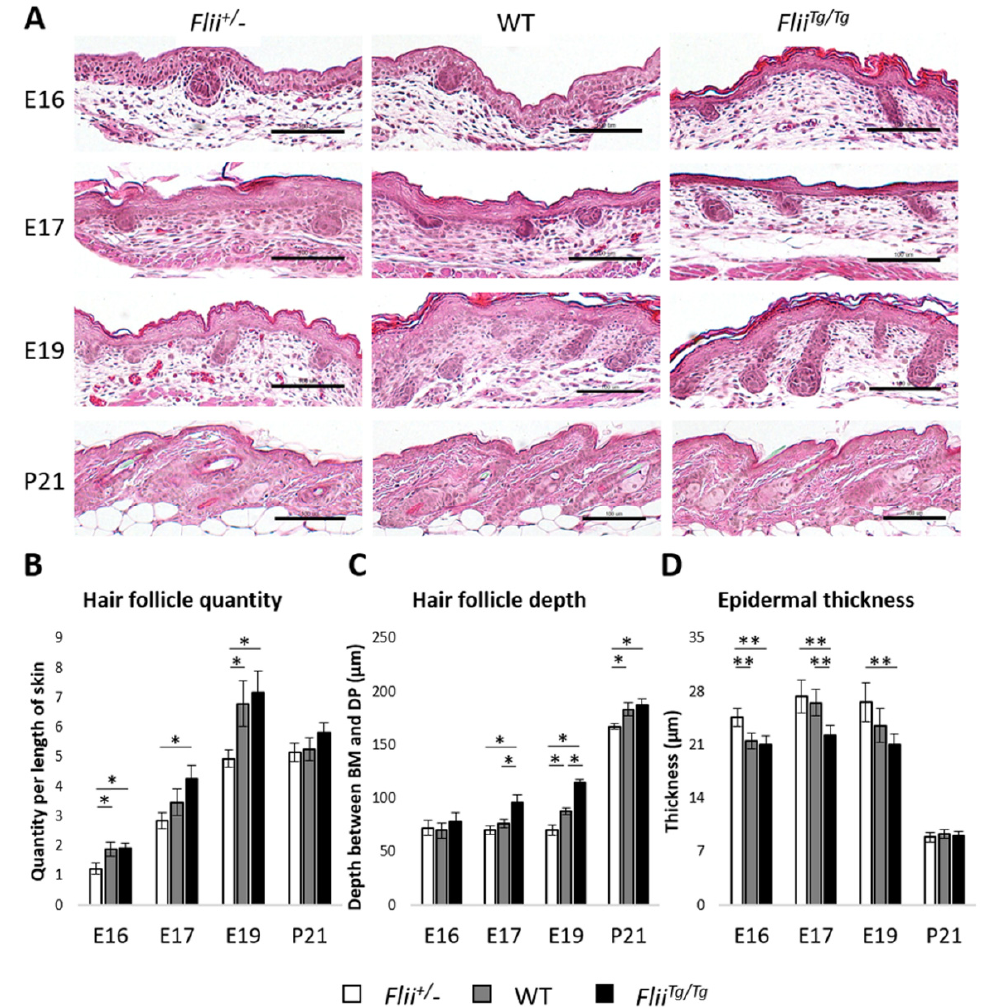
Figure 4. Morphogenesis of stratified epidermis and hair follicles is affected in mice expressing varying levels of Flii during late embryonic development. ( A ) Representative H&E images of the developing epidermis at different embryonic day including E16, E17, E19 and postnatal at P21. Flii +/ − , Flii knockdown; WT, wild-type; Flii Tg / Tg , Flii overexpressing. Scale bars, 100 µ m. ( B ) Hair follicle (including its infantile and juvenile forms as placodes and hair pegs) quantity was determined by measuring the number of developing hair follicle per length of skin ( C ) Hair follicle (including its infantile and juvenile forms as placodes and hair pegs) depth was determined by measuring the distance between basement membrane (BM) and dermal papilla (DP). ( D ) Epidermal thickness was determined by measuring the distance between BM and stratum granulosum in interfollicular regions across consistent length of epidermis at E16, E17, E19 and P21. N = 6. Mean ± SEM. * p < 0.05. ** p < 0.005.